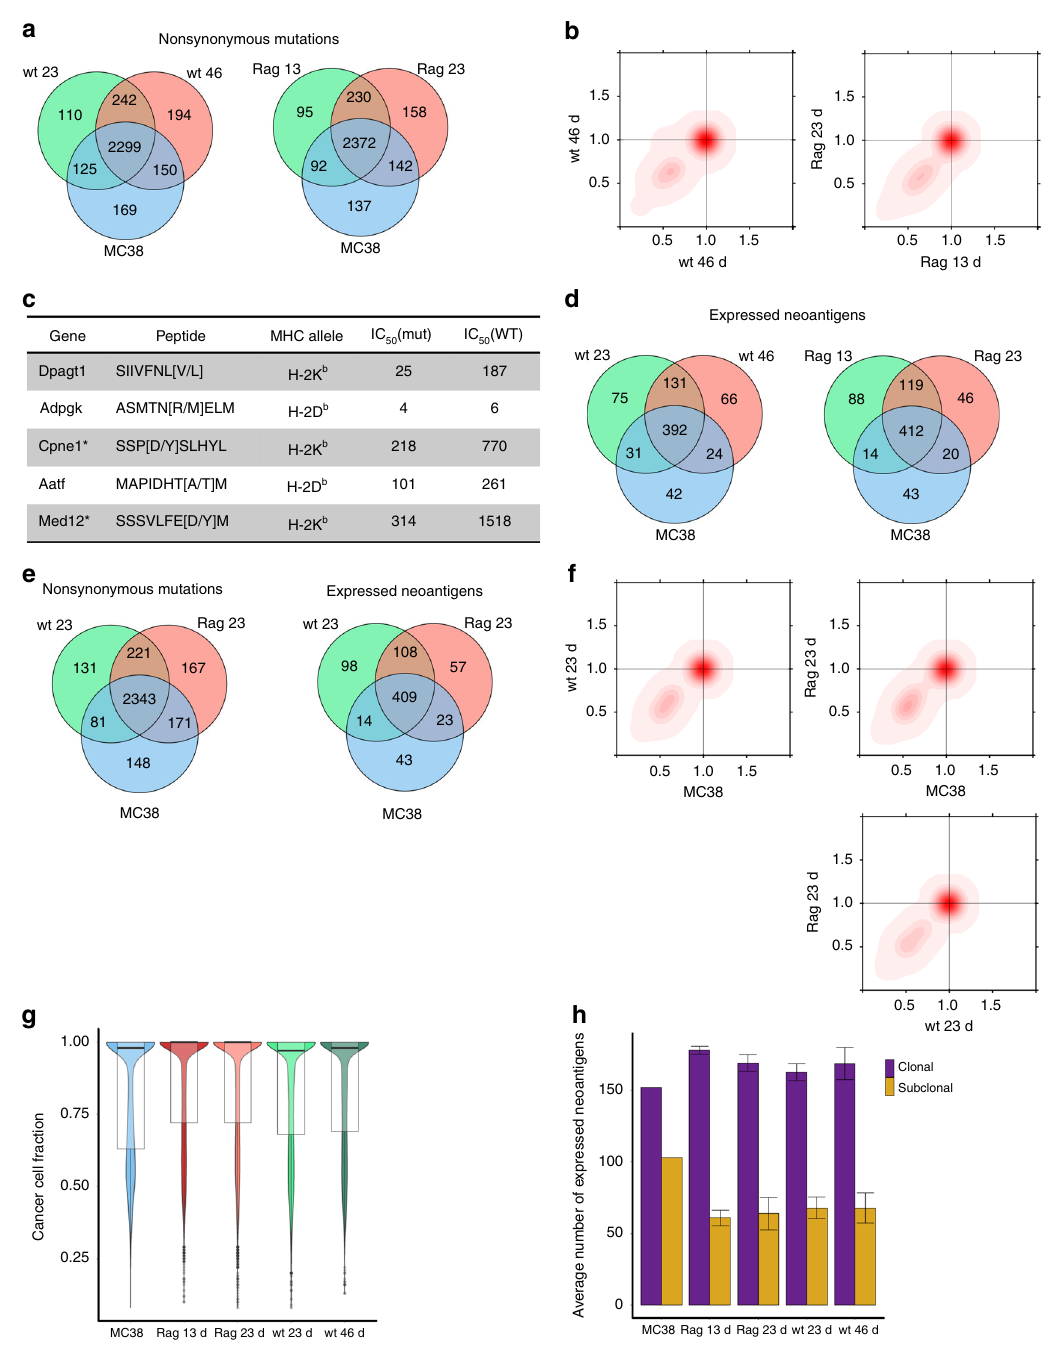
Fig. 3 Genomic and immunogenomic analyses of progressing tumors in wild-type and RAG1-/- mice. a Shared nonsynonymous mutations between MC38, and wild-type and RAG1 − / − samples during progression. Mutations found in at least one sample from the same type are considered. b Two-dimensional density plots showing the clustering of the cancer cell fractions of all mutations shared between two samples; increasing intensity of red indicates the location of a high posterior probability of a cluster. c Immunogenic neoantigens that were experimentally validated in a previous work 12 and detected in this study. Asterisks show epitopes that were predicted but not expressed. d Shared expressed neoantigens between MC38, and wild-type and RAG1 − / − samples during progression. Neoantigens found in at least one sample from the same type are considered. e Shared nonsynonymous mutations and expressed neoantigens between MC38, and wild-type and RAG1 − / − samples at day 23. Mutations and neoantigens found in at least one sample from the same type are considered. f Two-dimensional density plots showing the clustering of the cancer cell fractions of all mutations shared between two samples. g Violin plots showing tumor heterogeneity estimated from the cancer cell fractions ( n = 3 replicates for all samples expect MC38 where n = 1). Box plots show the median, the 25th and 75th percentiles. h Number of clonal and subclonal expressed neoantigens in MC38 and all tumor samples. Error bars represent standard error of the mean ( n = 3 replicates for all samples expect for MC38 where n = 1). Box plots show the median, the 25th and